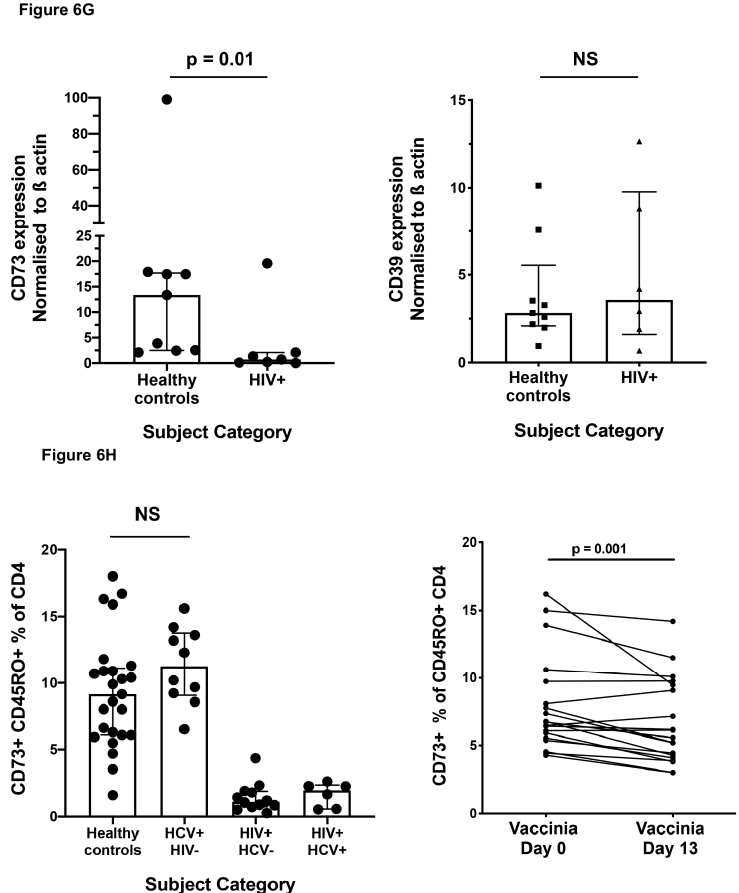
Figure 6. Progressive loss of CD73+ CD45RO+ CD4+ memory cells during HIV-1 infection. ( A ) Comparison of CD73+ cells as percentage of CD45RO+ memory CD4+ T cells in healthy adult controls, primary HIV-1 infection (PHI) subjects, chronic HIV-1 infection (CHI) subjects, HIV+ long-term survivors (LTNP) and HIV+ Elite controllers (Elite). ( B ) Graph of CD73+ CD45RO+ memory cells as percentage of CD4+ T cells versus CD38+ CD45RO+ memory cells as percentage of CD4+ T cells in the same samples, in healthy adult controls (small circles), compared to PHI subjects at presentation (triangles), CHI subjects (large solid circles) and acute EBV subjects (stars). ( C ) Prospective longitudinal data of CD73+ CD45RO+ memory cells as percentage of CD4+ T cells in n = 8 PHI subjects commencing antiretroviral therapy including integrase inhibitor. Results are from real-time analysis from baseline (BSL) to week 52. p values are for comparison to healthy adult control values from samples run over the same time period using the same method. ( D ) Prospective longitudinal data of CD73+ CD45RO+ memory cells as percentage of CD4+ T cells in n = 8 CHI subjects commencing antiretroviral therapy including integrase inhibitor, compared to healthy adult control values from samples run over the same time period using the same method. Results are from real-time analysis from baseline (BSL) to week 52. ( E ) Prospective longitudinal data of activated CD38+HLA-DR+ as a percentage of CD8+ T cells in n = 8 PHI subjects commencing antiretroviral therapy including an integrase inhibitor. Results are from the same real-time analysis from baseline (BSL) to week 52 as for Figure 2C, compared to healthy adult control values from samples run over the same time period using the same method. ( F ) Prospective longitudinal data of activated CD38+HLA-DR+ as percentage of CD8+ T cells in n = 8 CHI subjects commencing antiretroviral therapy including integrase inhibitor. Results are from the same real-time analysis from baseline (BSL) to week 52 as for Figure 2D, compared to healthy adult control values from samples run over the same time period using the same method. ( G ) Decreased expression of mRNA for CD73 ( NT5E ), by quantitative RT-PCR of purified CD4+ T cells from HIV+ subjects, compared to healthy controls (left graph), and mRNA for CD39 ( ENTPD1 ), which was not significantly different, in purified CD4+ T cells from HIV+ subjects, compared to healthy controls (right graph). ( H ) Comparison of CD73+ cells as percentage of CD45RO+ memory CD4+ T cells in healthy adult controls, compared to HIV+ subjects, hepatitis C virus (HCV) infected subjects and HIV and HCV-coinfected subjects (left graph), and for healthy adults at baseline and at day 13 post-inoculation with vaccinia virus (right graph).